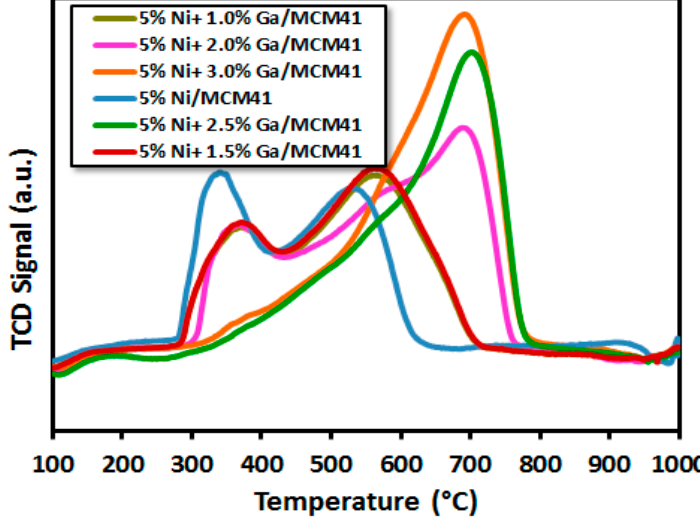
Figure 3. TPR patterns for promoted and non-promoted 5% Ni/MCM-41 catalysts.